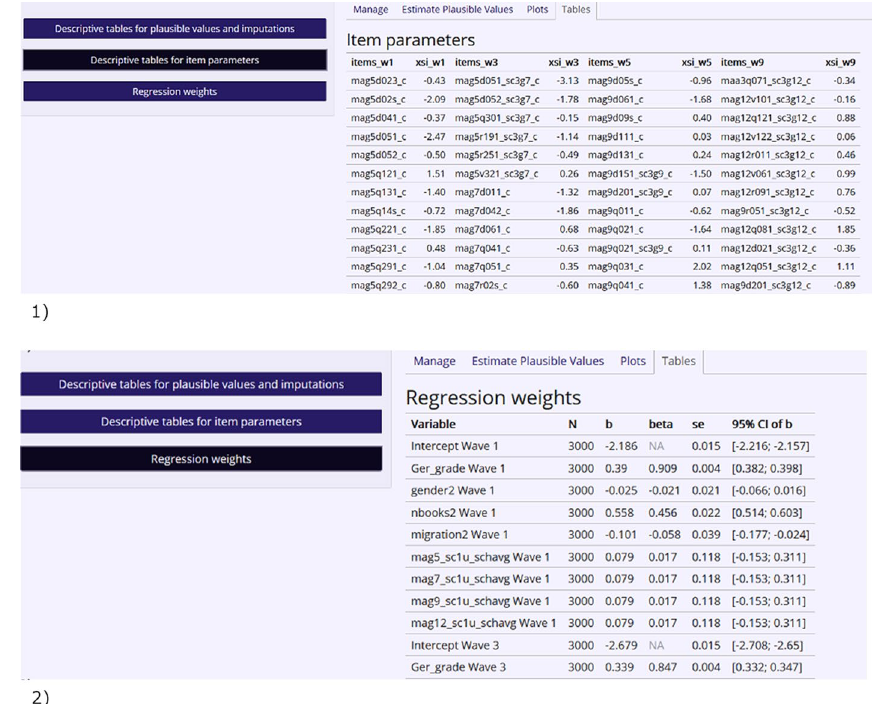
Fig. 6 Summary tables of (1) item and (2) regression